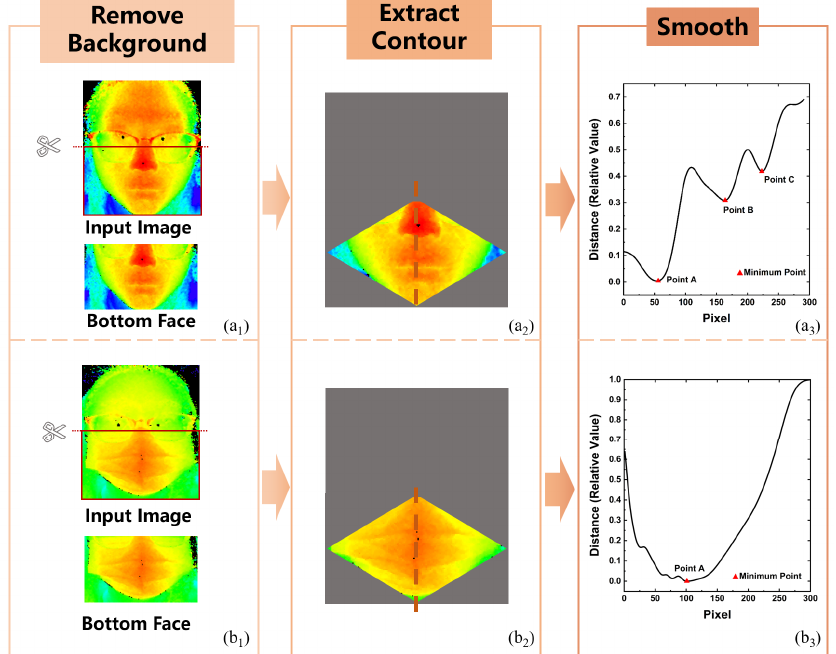
Figure 2. Overview of facial contour extraction. ( a ) Facial contour extraction of the image without a mask and ( b ) facial contour extraction of the image with a surgical mask.